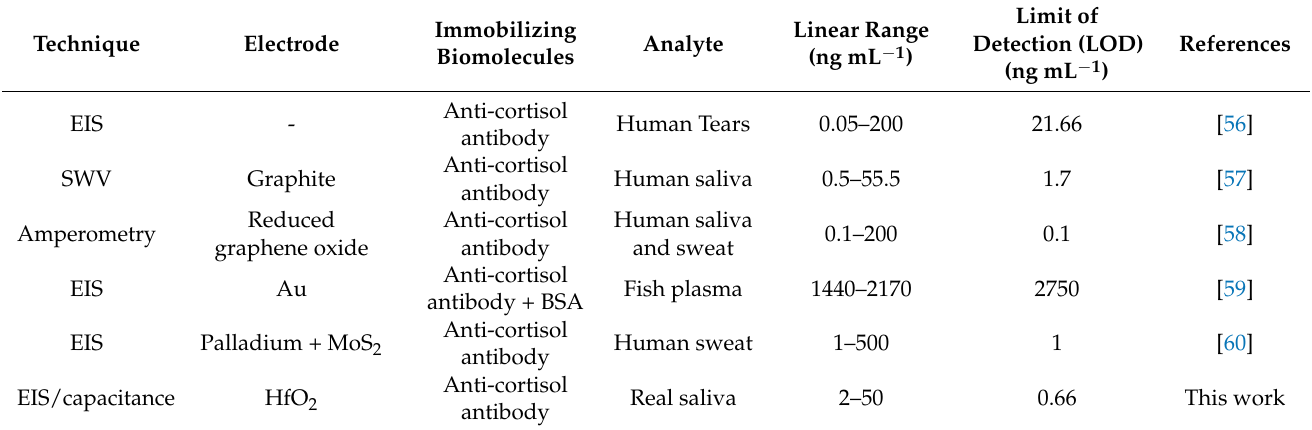
(Table 2). The detection limit of the HfO 2 /silicon-based immunosensor is in the lower range, and its detection range falls in the range of concentrations of cortisol for a healthy person and for a person with HF. Table 2. Comparison of the analytical performance of the HfO 2 /silicon-based immunosensor to those of the published electrochemical immunosensors for the detection of cortisol.